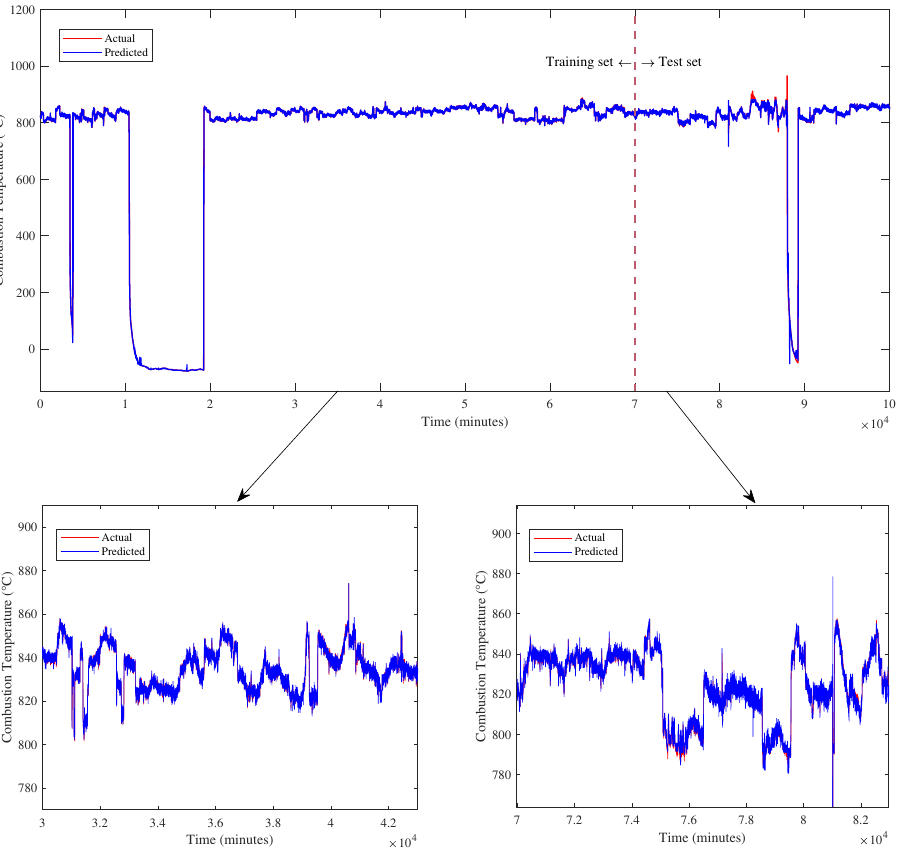
Figure 8. Combustion Temperature prediction from the proposed